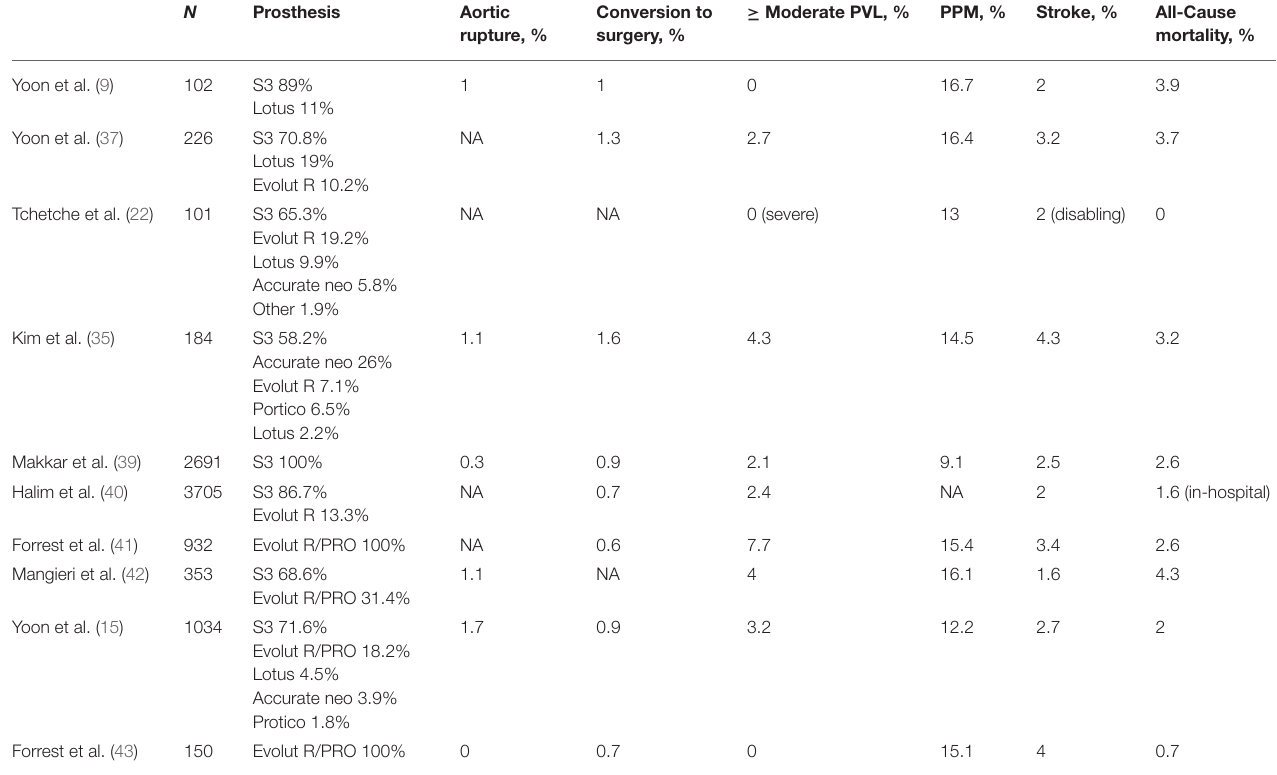
TABLE 1 | Summarizes major published studies including > 100 patients treated for bicuspid aortic valve (BAV) severe stenosis with the current generation of transcatheter heart valves. ≥ Moderate PVL, % PPM, % Stroke, % All-Cause N Prosthesis Aortic Conversion to rupture, % surgery, %